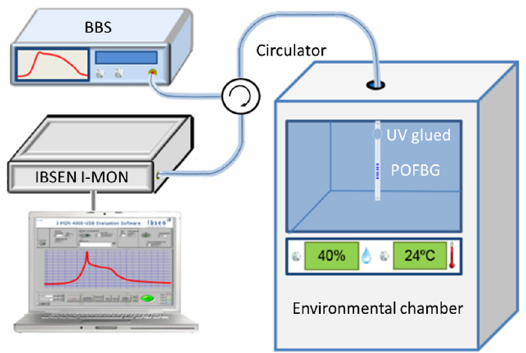
Figure 1. Experimental setup used in this work.